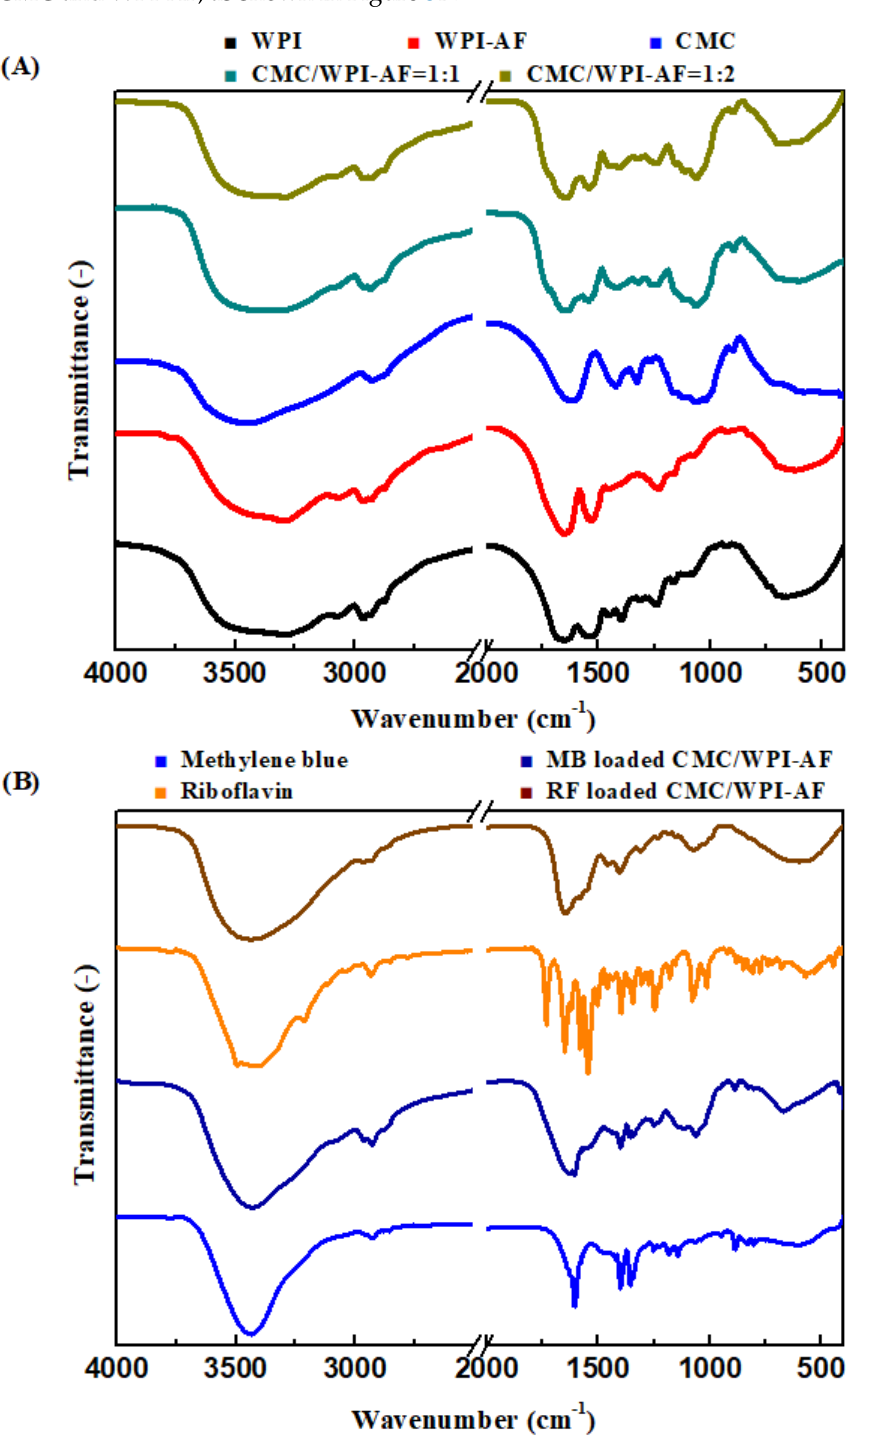
Figure 6. ( A ) Fourier transform infrared (FTIR) spectra of WPI, WPI - AF, CMC, and CMC/WPI - AF membranes. ( B ) FTIR spectra of methylene blue, riboflavin, MB - loaded CMC/WPI - AF membranes, membranes. ( B ) FTIR spectra of methylene blue, riboflavin, MB-loaded CMC/WPI-AF membranes, and RF - loaded CMC/WPI - AF membranes. and RF-loaded CMC/WPI-AF